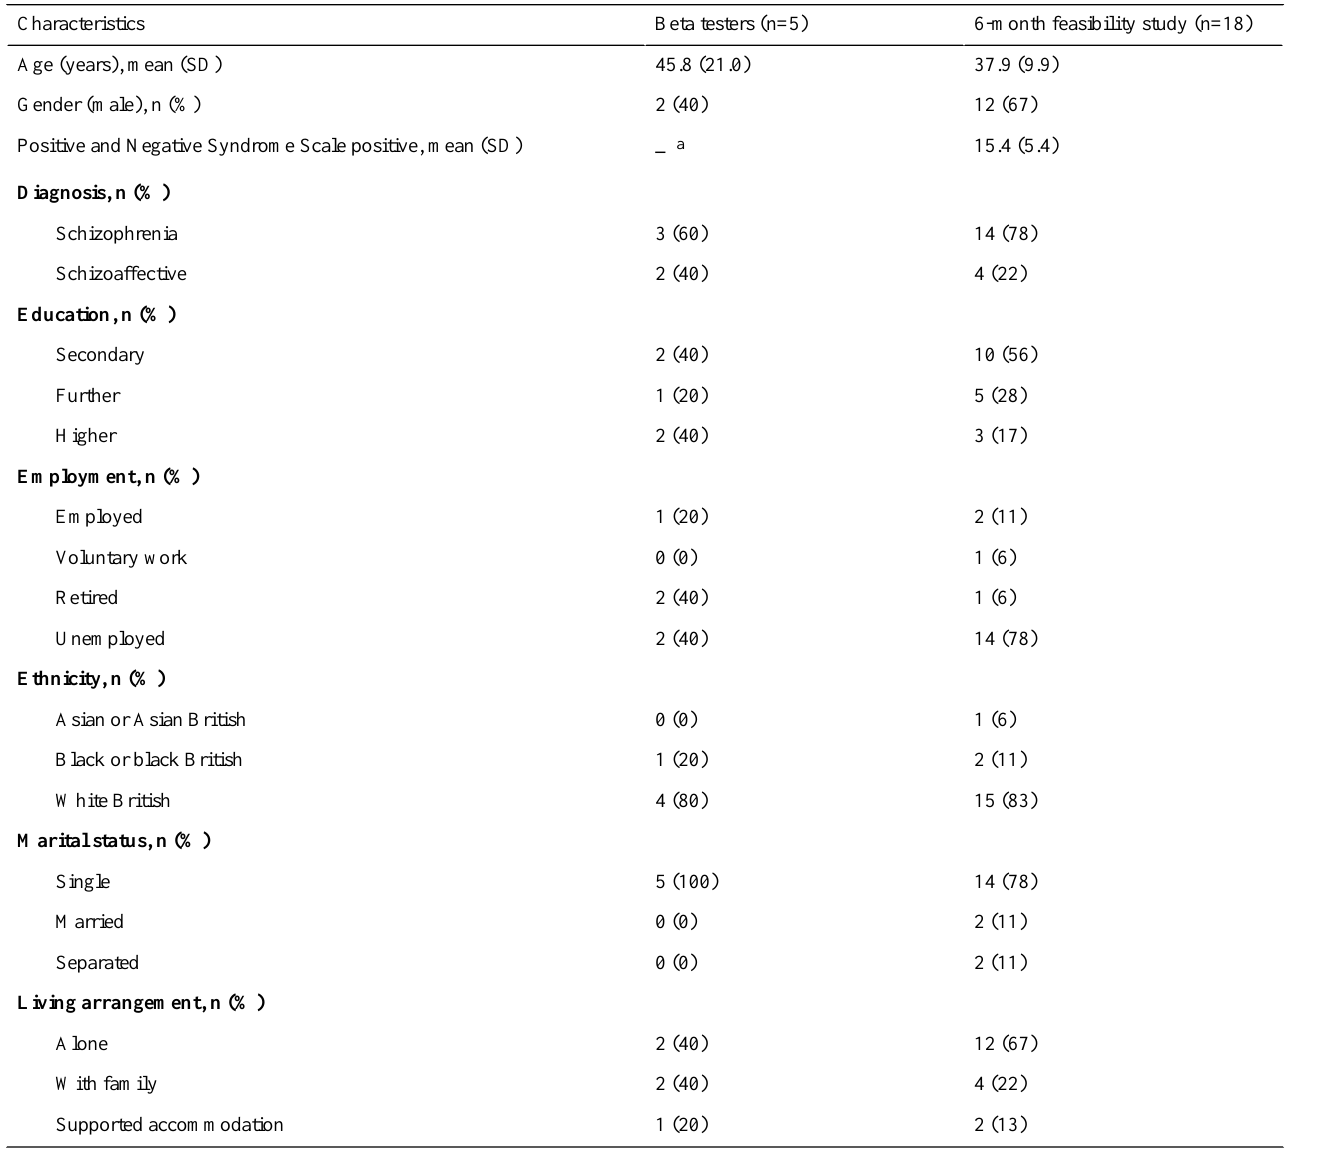
Table 4. Clinical and demographic characteristics of the 2 patient samples.